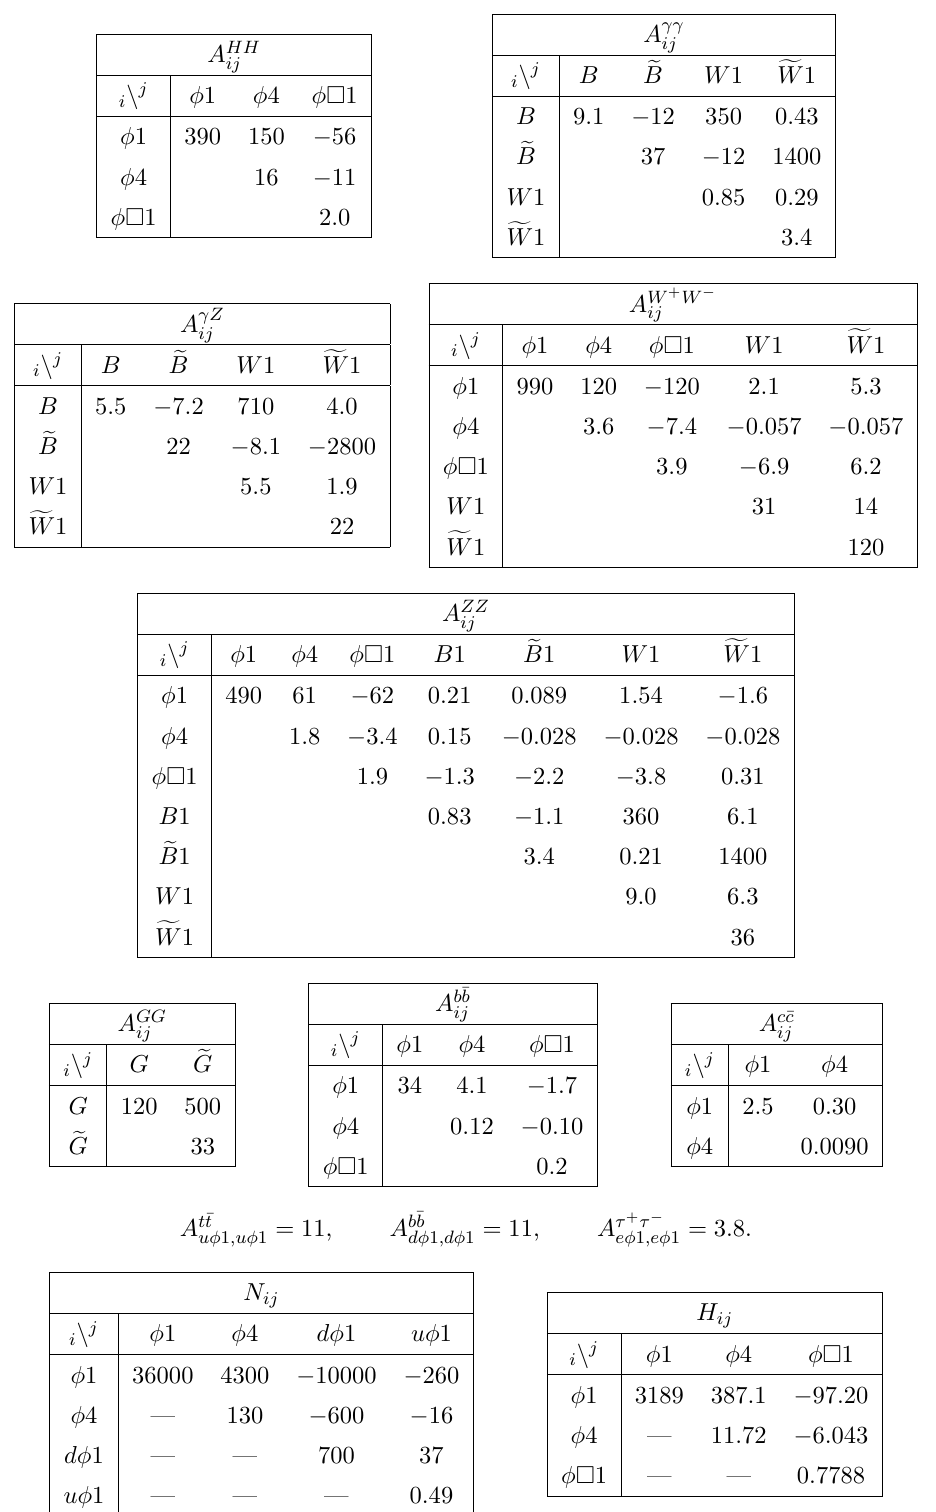
, N and H in the semi-analytical formulas for the DM annihilation ij ij ij